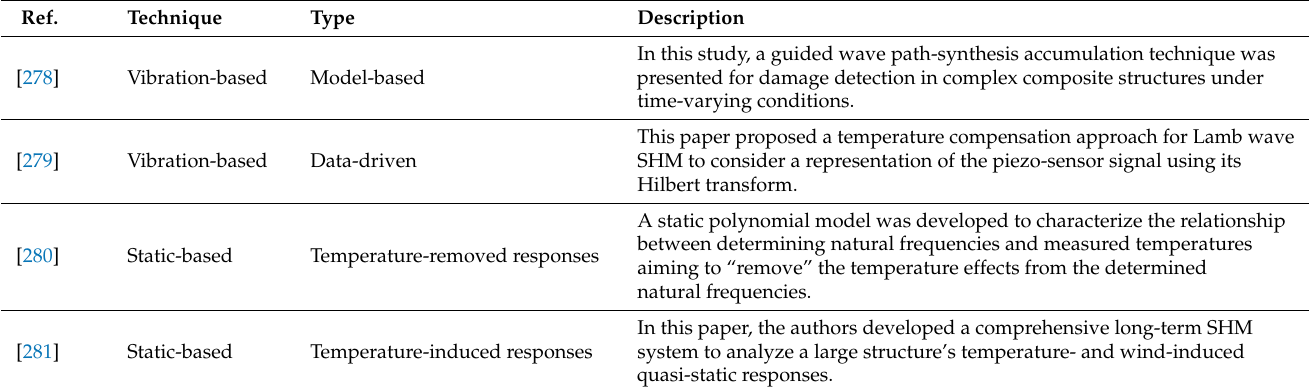
Table 6. Examples of data analysis techniques considering